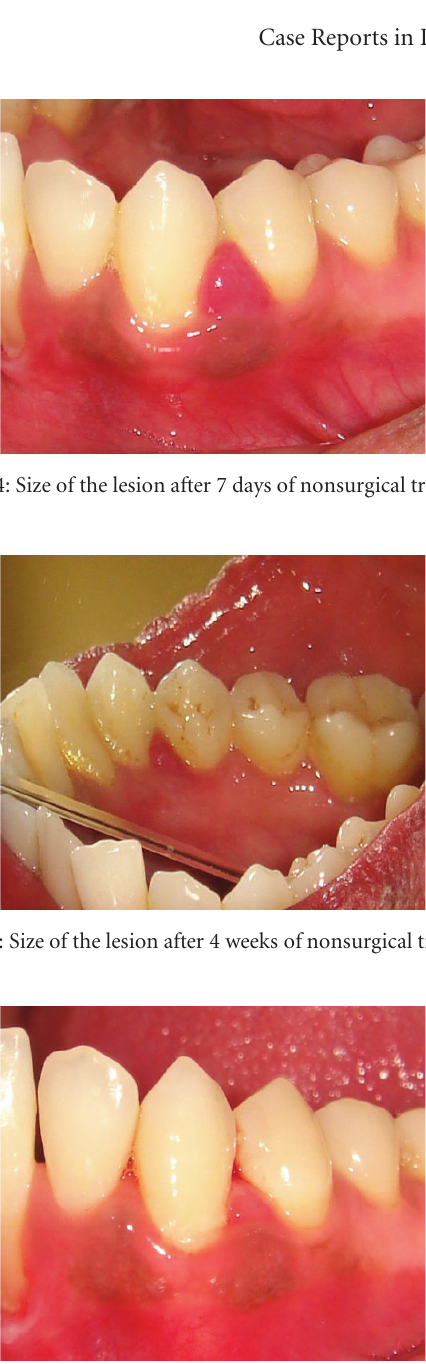
Figure 6: Size of the lesion after 6 monthsof nonsurgical